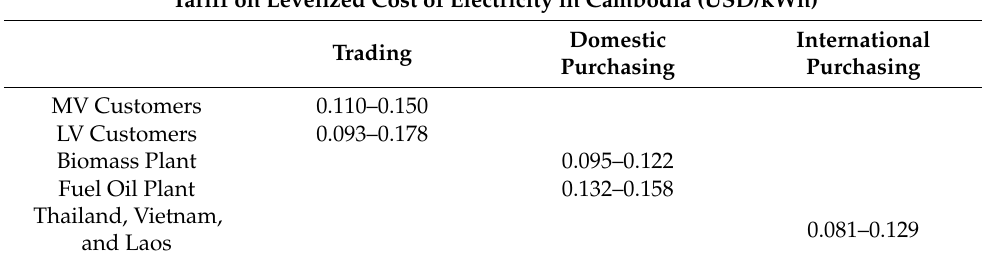
Table 3. The LCOE of trading and purchasing of electricity in